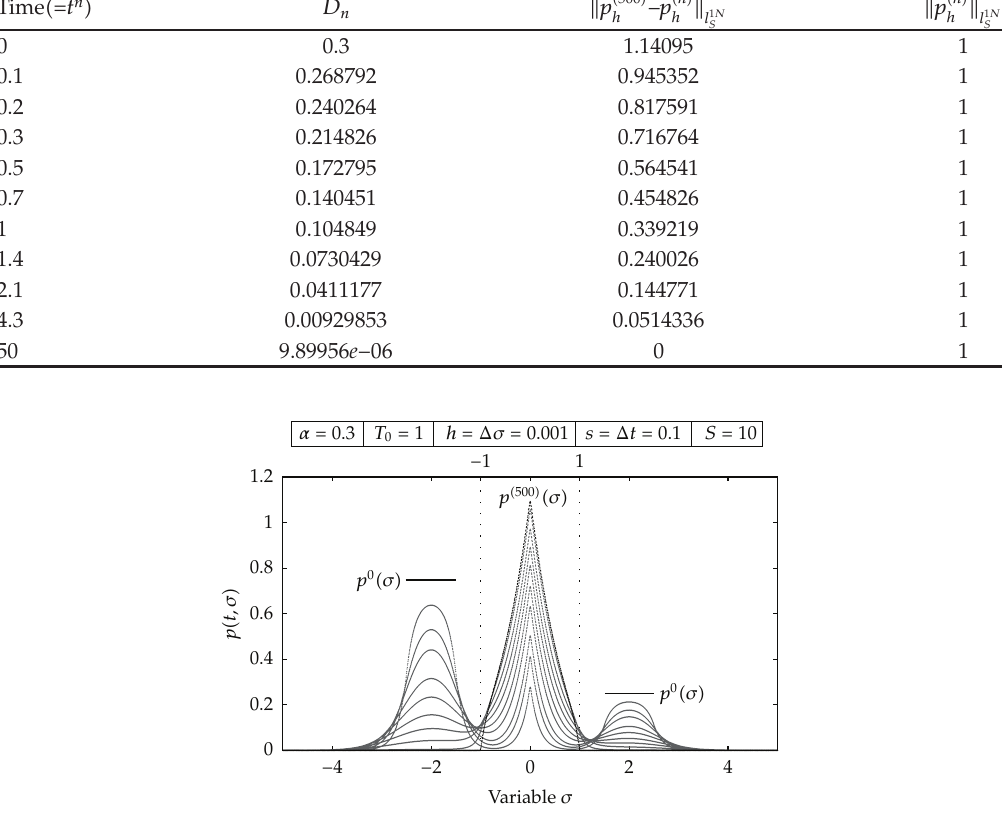
Figure 8: Graphics sequence: Subcase